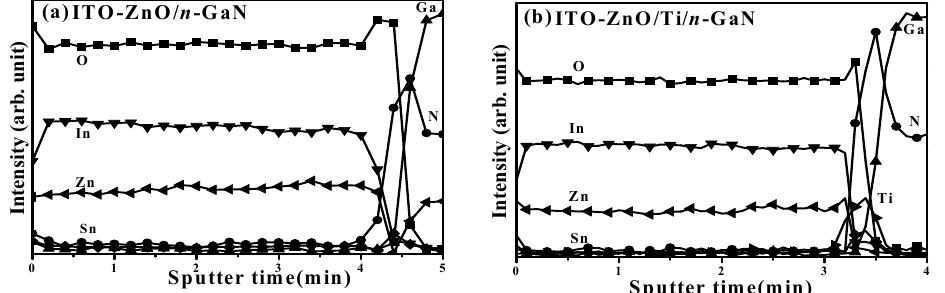
Figure 7. Elemental distributions of ( a ) the cosputtered ITO-ZnO film directly contacting the n -GaN epilayer and ( b ) the ITO-ZnO/ n -GaN contact system inset by an 8-nm-thick Ti layer conducted from AES depth profile measurements.